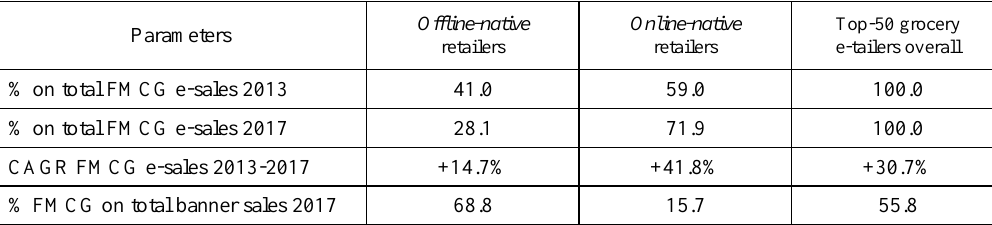
Table 2: Offline versus online-native retailers’ parameters Offline-native Parameters